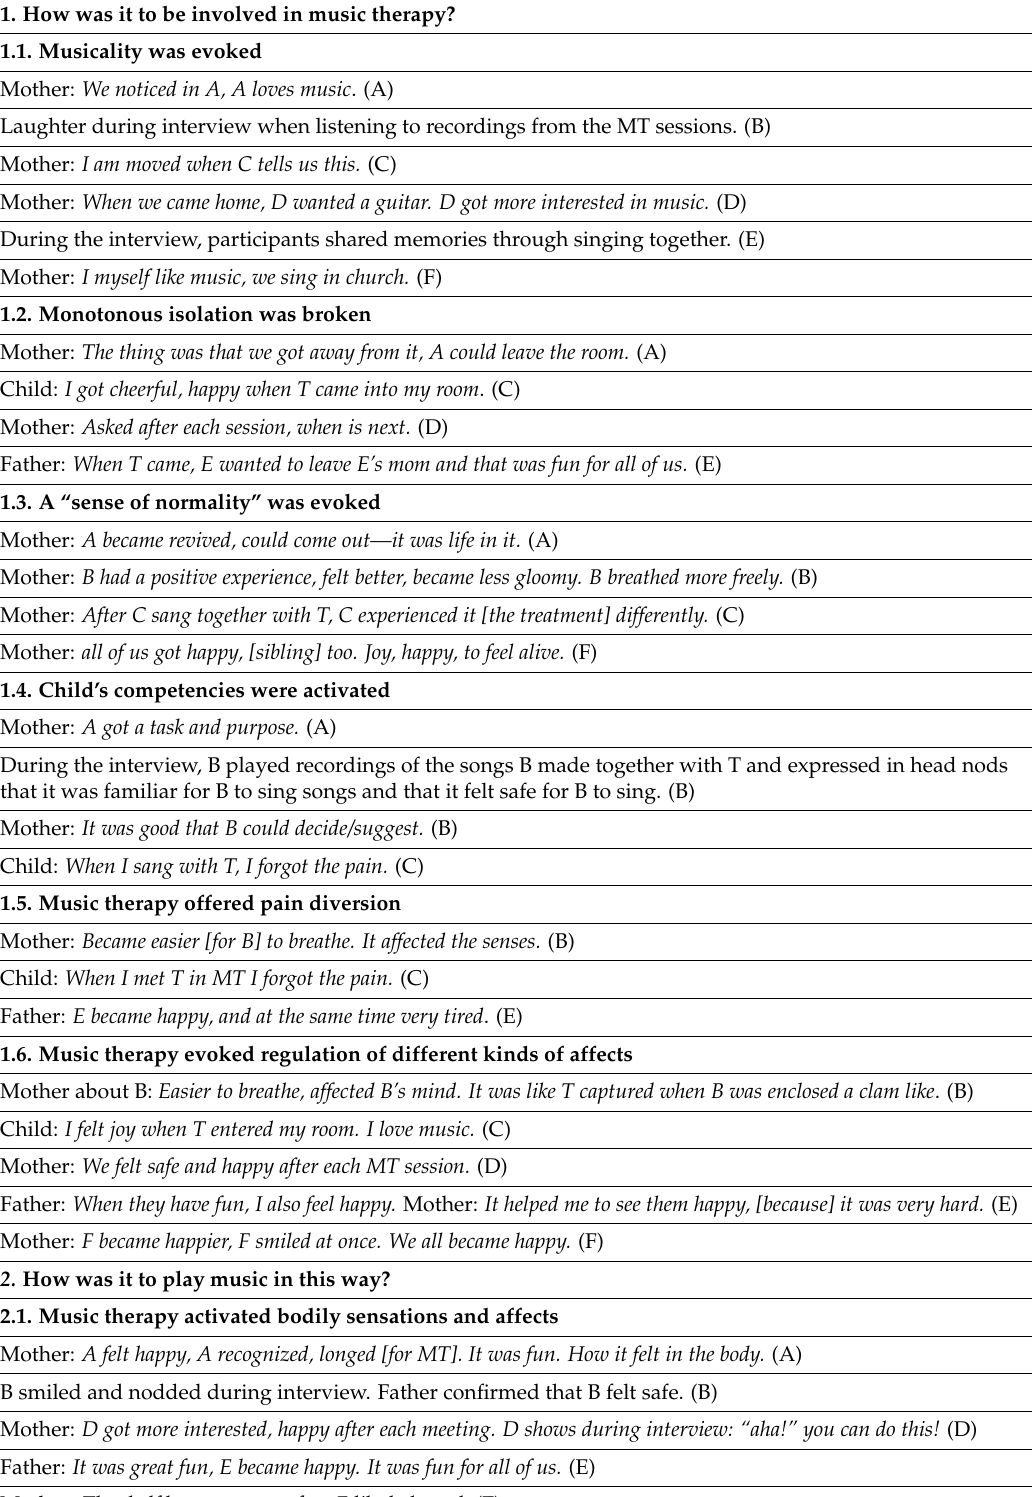
Table A2. Excerpts from the analysis of interviews with six children and their parents after receiving music therapy. Participants included: A, post-HSCT; B, during HSCT; C, during HSCT; D, post-HSCT; E, during HSCT; F, post HSCT. Music therapist is abbreviated as T. Verbal testimonies are in italics and the interviewer’s memories of interactions are in ordinary